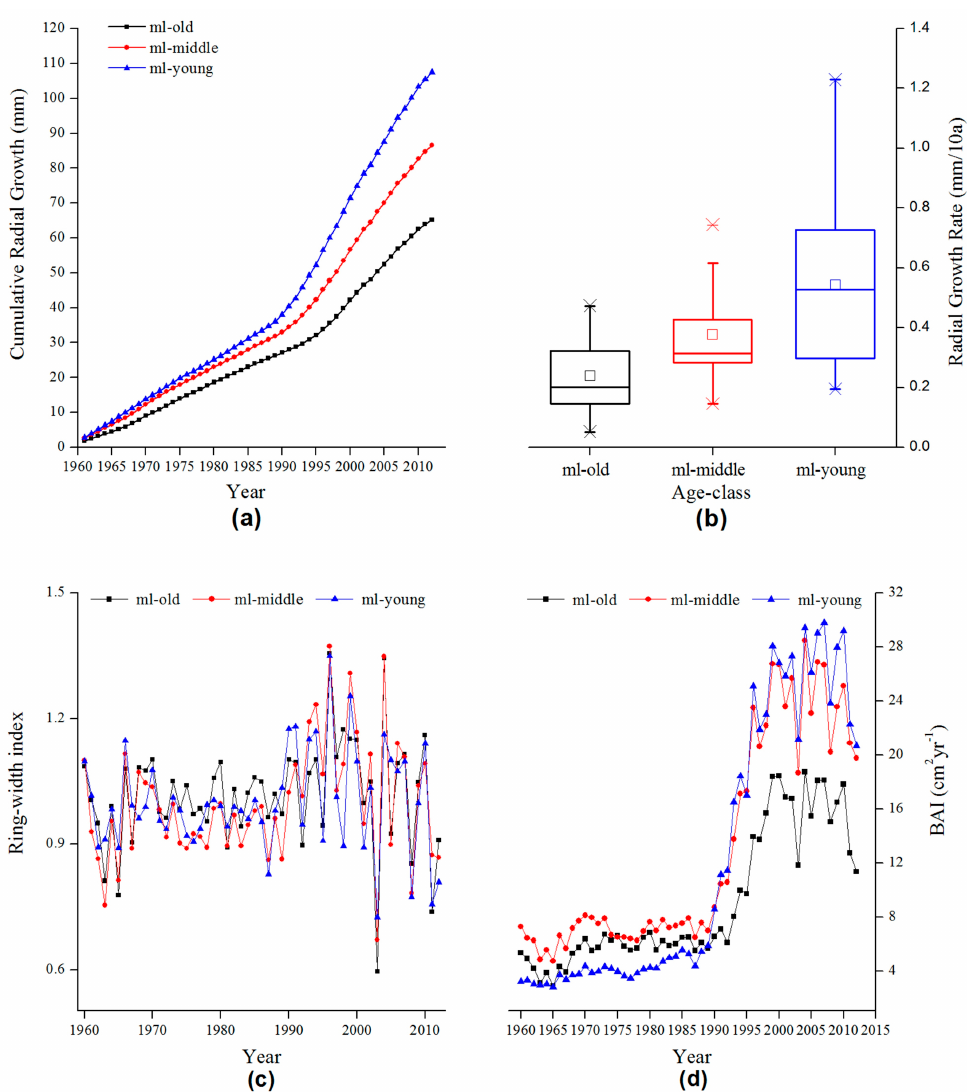
Figure 3. The trend of radial growth from three age ‐ classes of Schrenk spruce trees during 1960–2012 in the eastern Tianshan Mountains (the black lines represent the old age ‐ class of trees; the red lines represent the middle age ‐ class of trees; the blue lines represent the young age ‐ class of trees). ( a ) the time trend of cumulative radial growth (mm); ( b ) the boxplots of radial growth rate (mm/10a), the solid lines represent the median and the squares represent the mean radial growth rate; ( c ) the tree ‐ ring width residual chronologies; and ( d ) the basal area increment (BAI, cm 2 yr − 1 ).